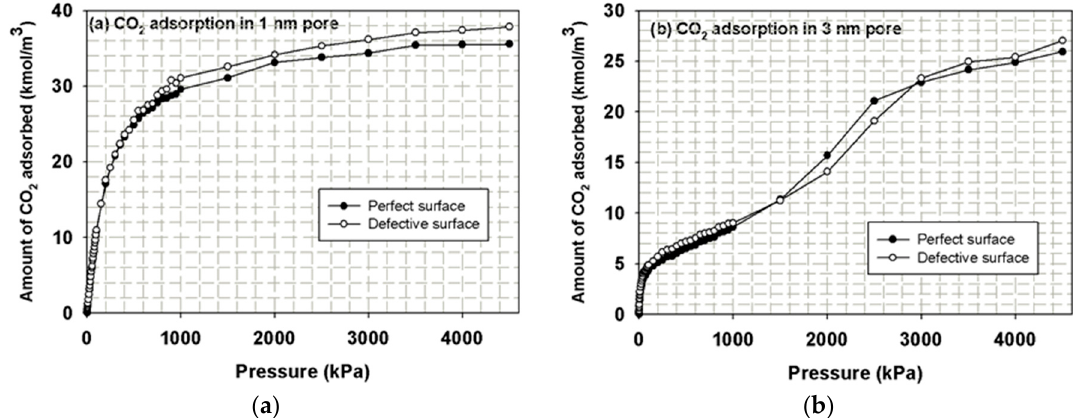
Figure 15. CO 2 adsorption on perfect and defective surfaces of pore walls of ( a ) 1 nm and ( b ) 3 nm pore widths .